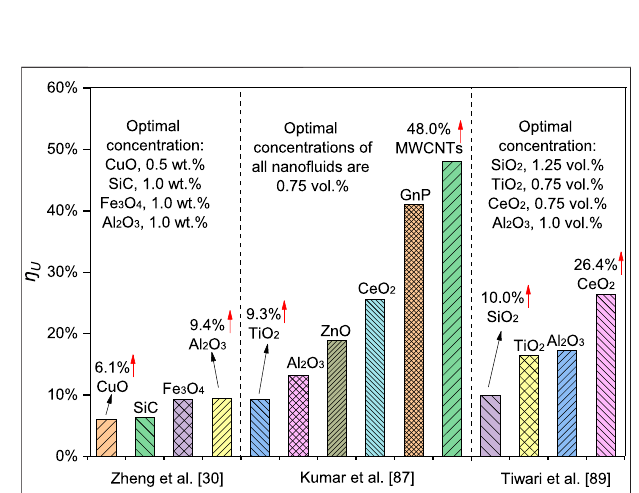
FIGURE 9 | Overall heat transfer coef fi cient enhancements of various nano fl uids with the optimum concentration at a fl ow rate of 3 lpm.